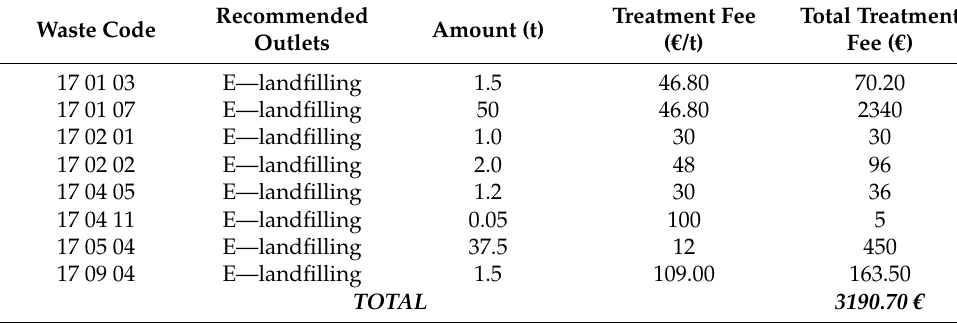
Table 11. Economic analysis of waste management by landfilling—variant